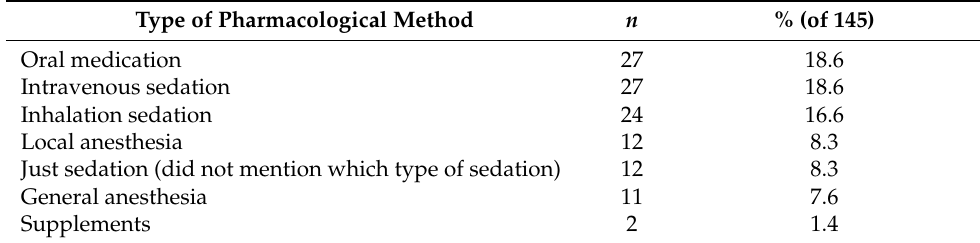
Table 7. Type of pharmacological method mentioned in the